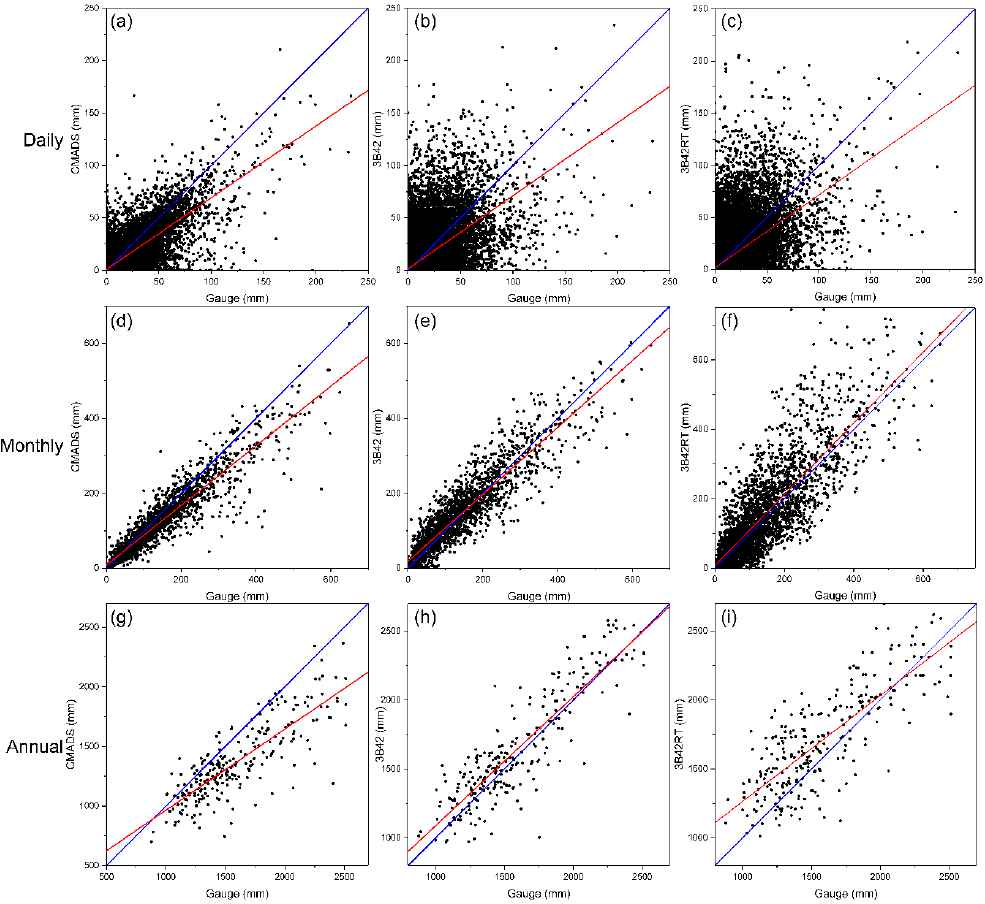
Figure 2. Scatterplots of precipitation comparison at selected pixels with rain gauges for CMADS (left column), 3B42 (middle column) and 3B42RT (right column) in the GRB: ( a – c ) at the daily time scale, ( d – f ) at the monthly time scale and ( g – i ) at the annual time scale. The diagonal line is blue, and the best-fit line estimated by the OLS (ordinary least square) method is red.